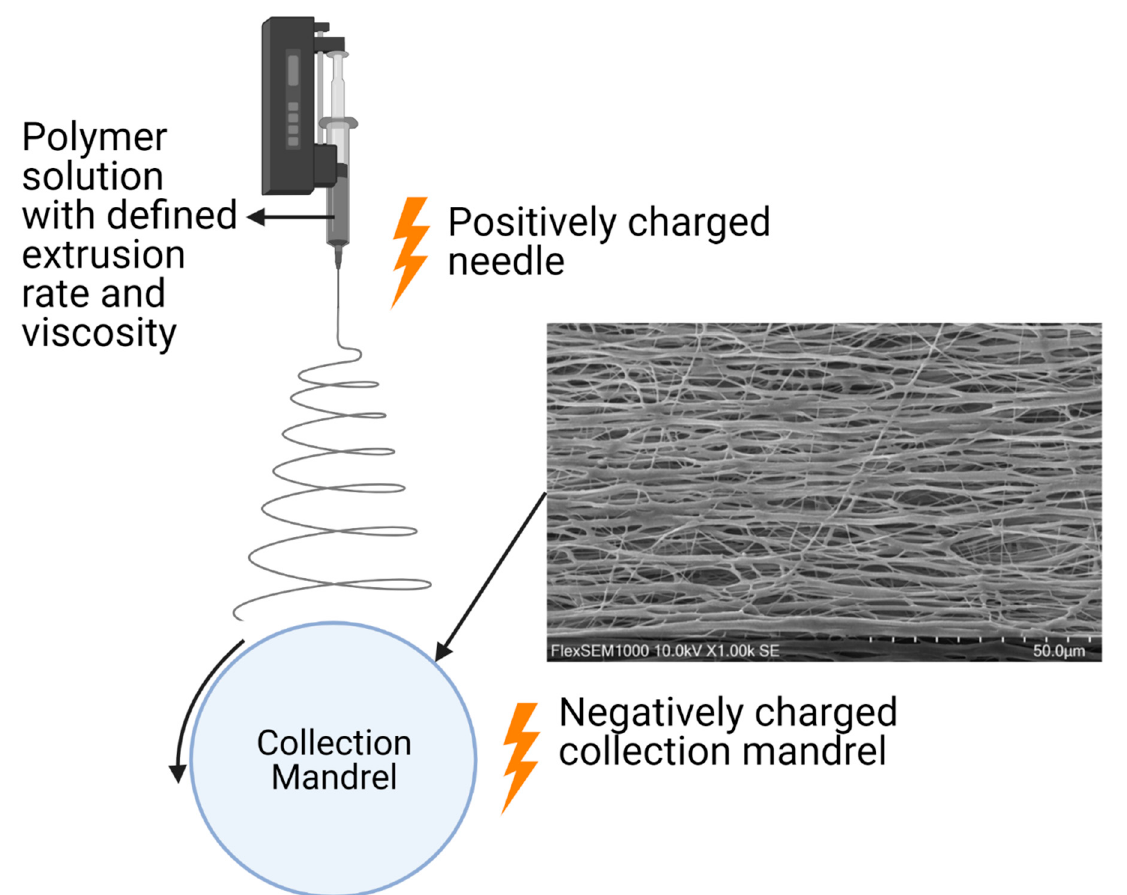
Figure 3. The electrospinning process with a scanning electron microscopy image of an electrospun scaffold taken by the author. Created with BioRender.com, accessed on 8 April 2022.